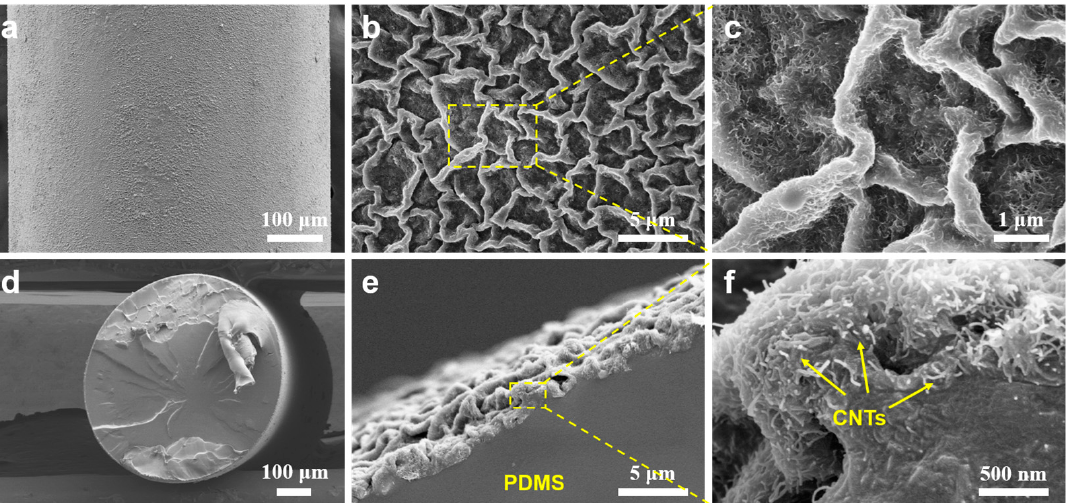
Figure 2. ( a – c ) Surface morphologies of CNTs@PDMS fiber. ( d – f ) Cross-section morphologies of CNTs@PDMS fiber. The embedded CNTs are denoted by the yellow arrows.